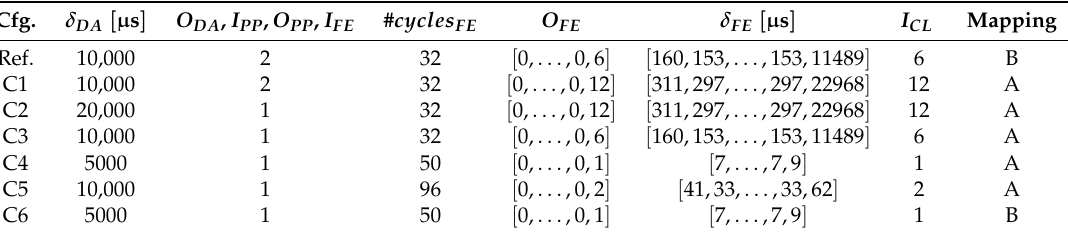
Table 2. Graph parameters of all